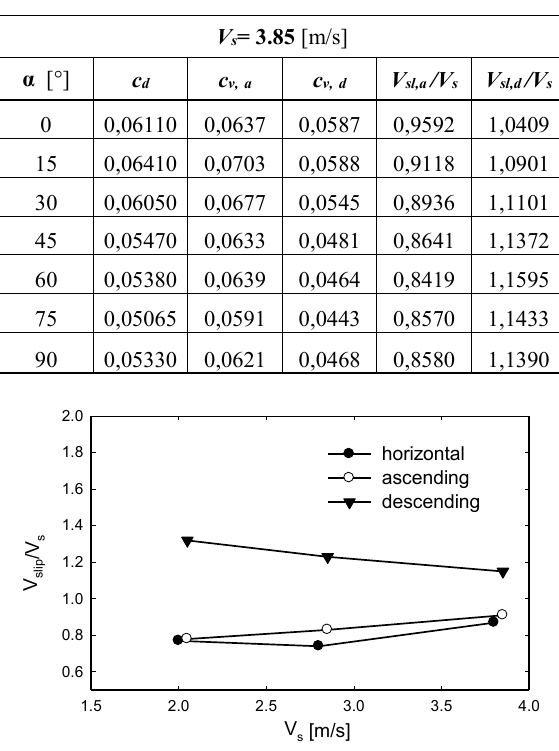
Table 2. Effect of pipe inclination angle α on slip ratio in ascending V sl,a /V s , and descending V sl,d /V s pipe sections.